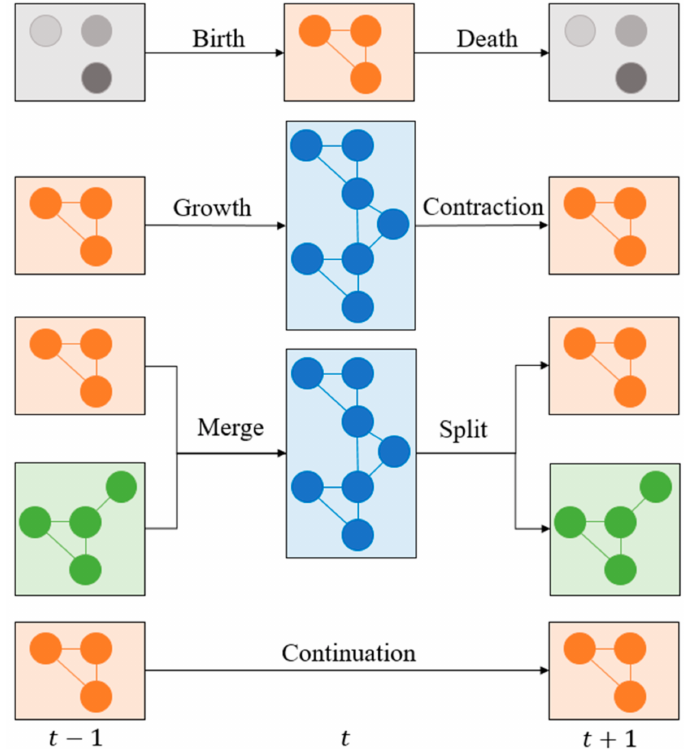
Figure 2. Seven kinds of community evolution